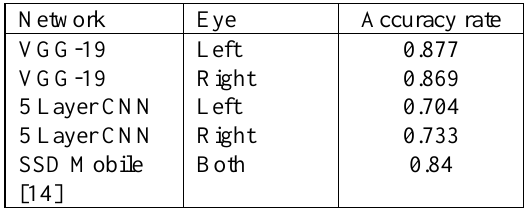
Table 3 . Proportion of correct recognition based on data from a video